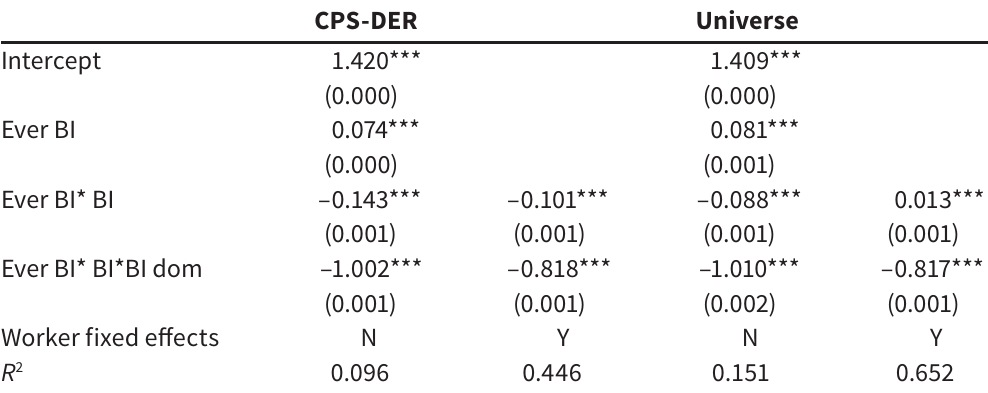
Number of wage and salary jobs worked regressed on